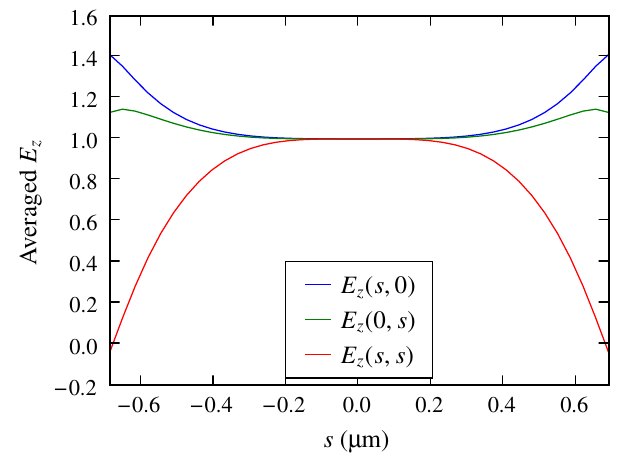
FIG. 10. Lineouts of average accelerating field seen by a speed-of-light particle, normalized to the accelerating field on axis. The fields are shown along the x axis (blue), the y axis (green), and the x (cid:3) y diagonal (red).